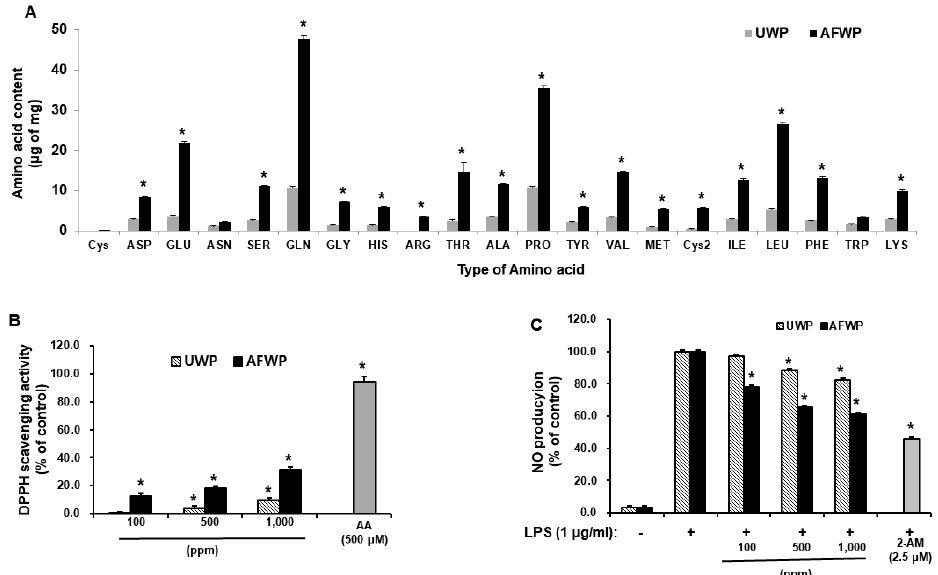
Figure 1. Effects of Aspergillus oryzae-fermented wheat peptone (AFWP) on amino acid composition and antioxidant activity. Effect of AFWP on amino acid composition ( A ), 2,2-diphenyl-1-picrylhydrazyl (DPPH) radical scavenging activity ( B ) and NO production ( C ). ( B ) AFWP or unfermented wheat peptone (UWP) was reacted with DPPH in the dark at 37 °C for 30 min. Absorbance at 517 nm was measured by spectrophotometry. Ascorbic acid (AA) was used as a control compound. ( C ) RAW 264.7 cells were incubated with AFWP or UWP in the presence of lipopolysaccharide (LPS, 1 μ g/mL) for 48 h. After the incubation, levels of NO were measured, and 2-amino-4-methylpyridine (2-AM) was used as a control compound. The results were confirmed using four independent experiments. Each experiment was conducted in duplicate. All data are presented as the mean ± SEM of four independent experiments. Statistical significance of differences among the groups was assessed by one-way analysis of variance (ANOVA), followed by Tukey’s multiple-comparison test, using the GraphPad Prism 5 software. * p < 0.05 vs. control group. AFWP: Aspergillus oryzae-fermented wheat peptone, UWP: unfermented wheat peptone.